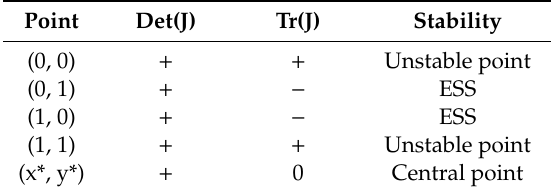
Table 7. Stability analysis of the points in case